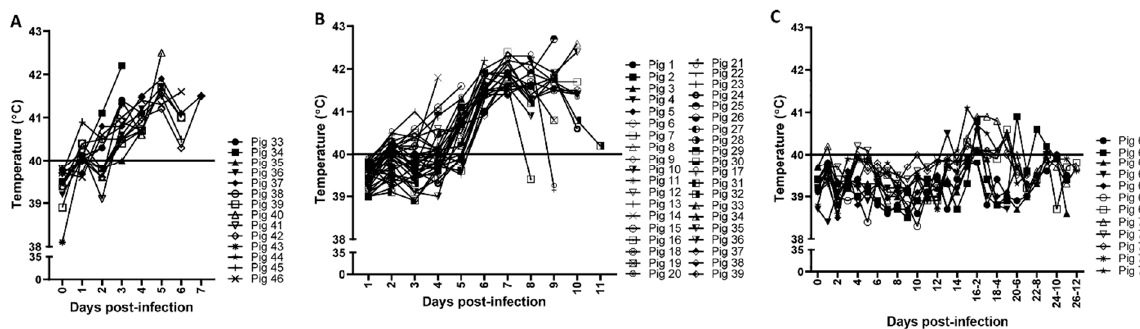
Figure 1. Rectal temperatures in pigs infected with ASFV Malawi LIL 18/2, ASFV Estonia 2014, or ASFV OURT/88/3. Groups of pigs ( n = 12–39) were infected oronasally with 1 × 10 5 TCID 50 ASFV Malawi LIL 18/2 ( A ), 2 × 10 5 TCID 50 ASFV Estonia 2014 ( B ), or 1 × 10 5 TCID 50 ASFV OURT/88/3 ( C ), and on the indicated dpi, the rectal temperatures of the pigs were recorded and plotted. For the ASFV OURT 88/3 group, pigs were re-infected with a dose of 1 × 10 6 TCID 50 ASFV OURT 88/3 on 14 dpi. Cut-off = 40 ° C.